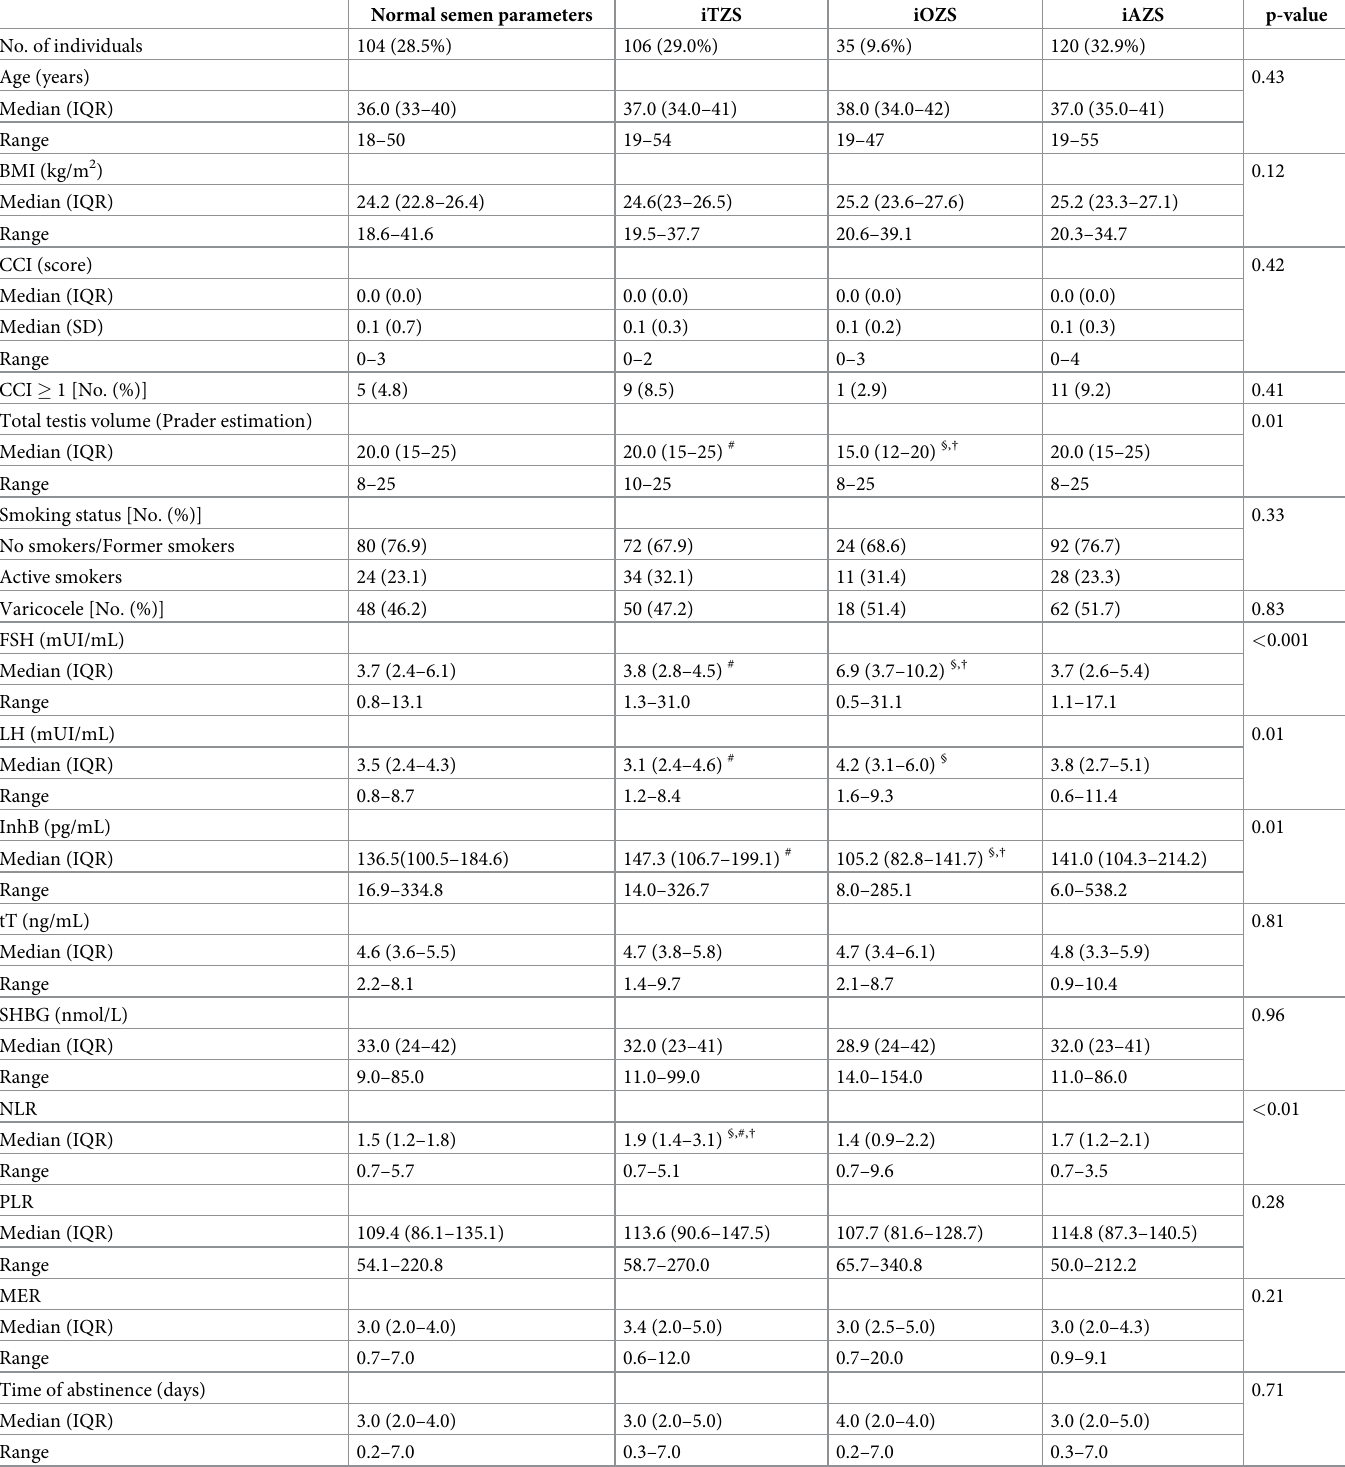
Table 2. Descriptive statistics of the cohort of infertile patient units (No. =